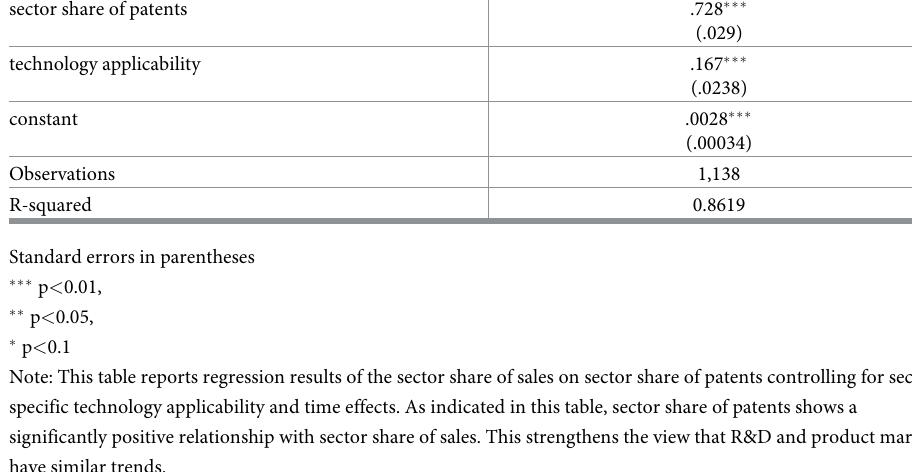
Table 3 is sector-level evidence about the significantly positive relationship between sales and patent shares. It’s consistent with Fig 8 which plots industry-level HHI of product and R&D markets. This regression result not only provides data support for the relationship at the sector level, but also provides a basis for the connection of the two shares at the firm level. And I will show you firm-level evidence next.